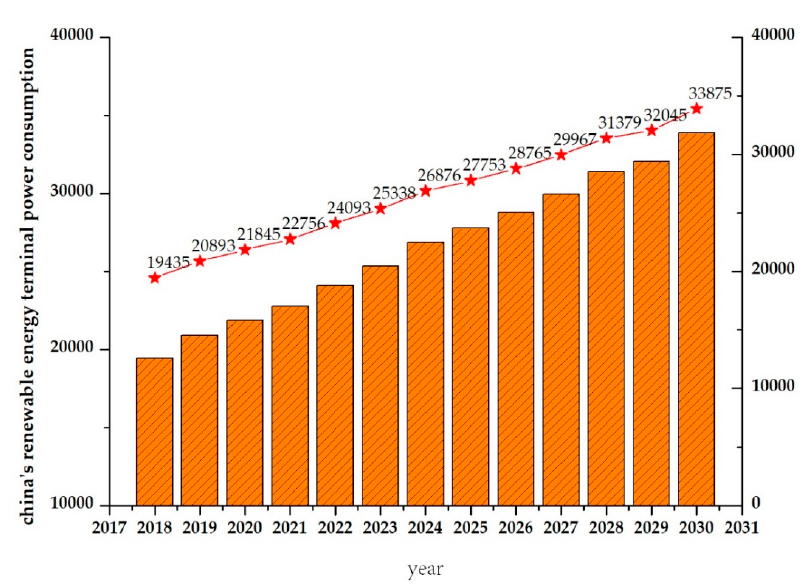
Figure 8. Output result of the EMD-BFO-IELM forecasting model.